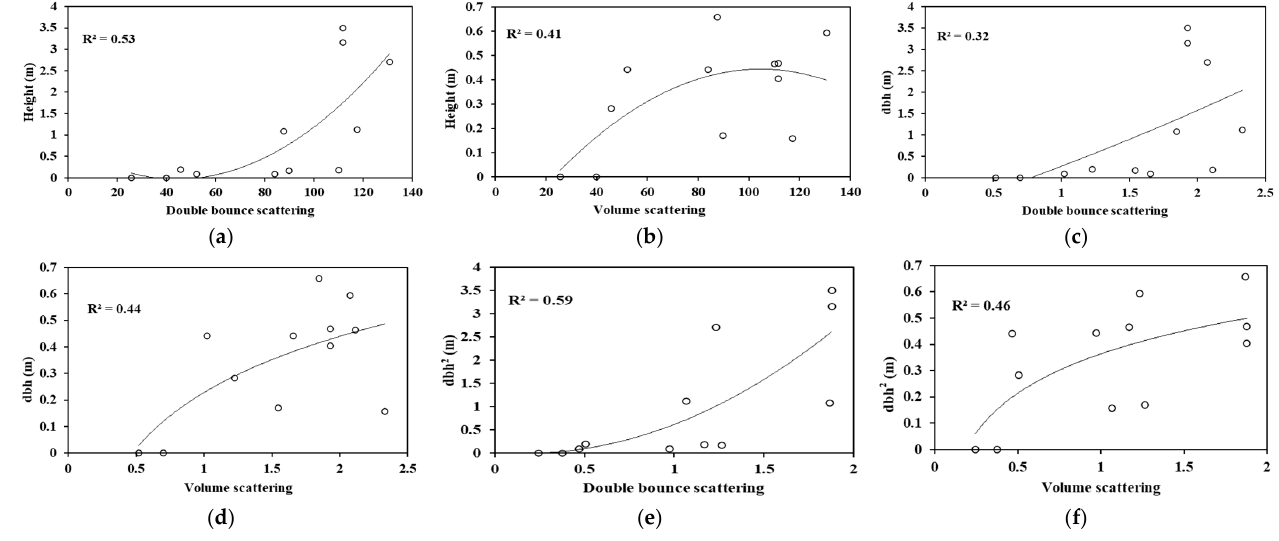
Figure 9. ( a – f ) Correlation plots of the ALOS PALSAR and TLS-derived variables. The double-bounce scattering component showed a correlation of 0.32 with dbh, which was a high-order relation, while dbh and volume scattering were log-transformed, yielding an R 2 value of 0.44. A linear relation was found between dbh 2 , double-bounce, and the volume-scattering components. The correlation value was enhanced to 0.59 with the high-order polynomial relation for dbh 2 and double-bounce, while the dbh 2 and vol- ume scattering were log transformed to show some relation, yielding an R 2 value of